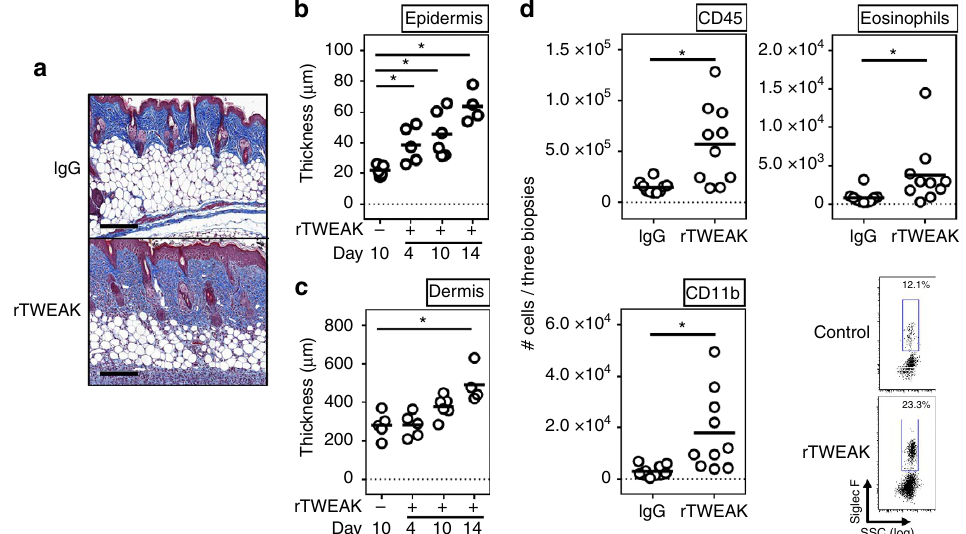
Figure 3 | rTWEAK induces skin inflammation. ( a , b ) Naive WTmice were injected with 75 m g mouse rTWEAK or IgG, administered s.c. either four times during a 14day period ( a ), or once with analysis on day 4, or twice weekly with analysis on day 10 ( b , c ). ( a ) Masson’s trichrome staining of representative skin sections on day 14. Scale bar, 200 m m. ( b , c ) Epidermal and dermal thickness on days 4, 10 and 14. Results are combined from two independent experiments. ( d ) Absolute number of skin-infiltrating cells measured by flow cytometry on day 4, and representative flow plot of skin-infiltrating eosinophils (SigF þ CD45 þ CD11b þ Ly6G (cid:2) cells). Combined from two experiments. Each data point one animal. Bars represent mean values. The ANOVA test with Bonferroni Correction was performed to compare the groups. Asterisks indicate P o 0.05. n.s. indicates nonsignificant differences. ANOVA, analysis of